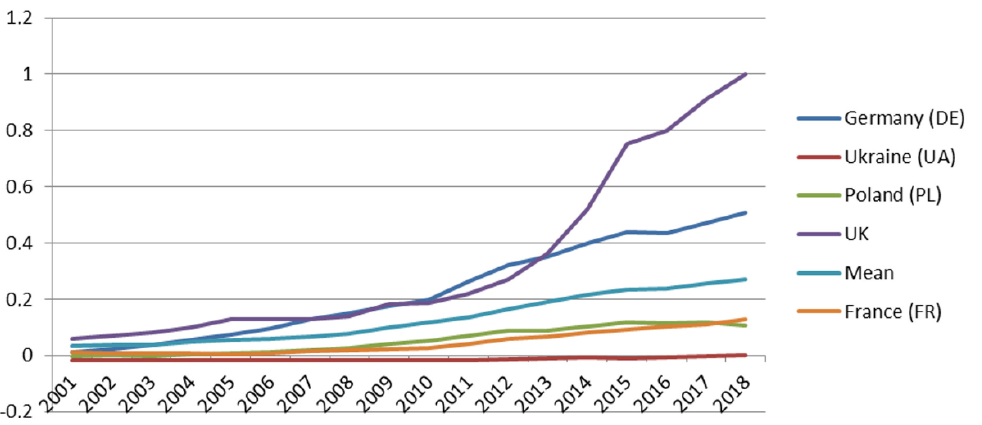
Figure 10. Changes in measure values for selected European countries (2018 real pattern).